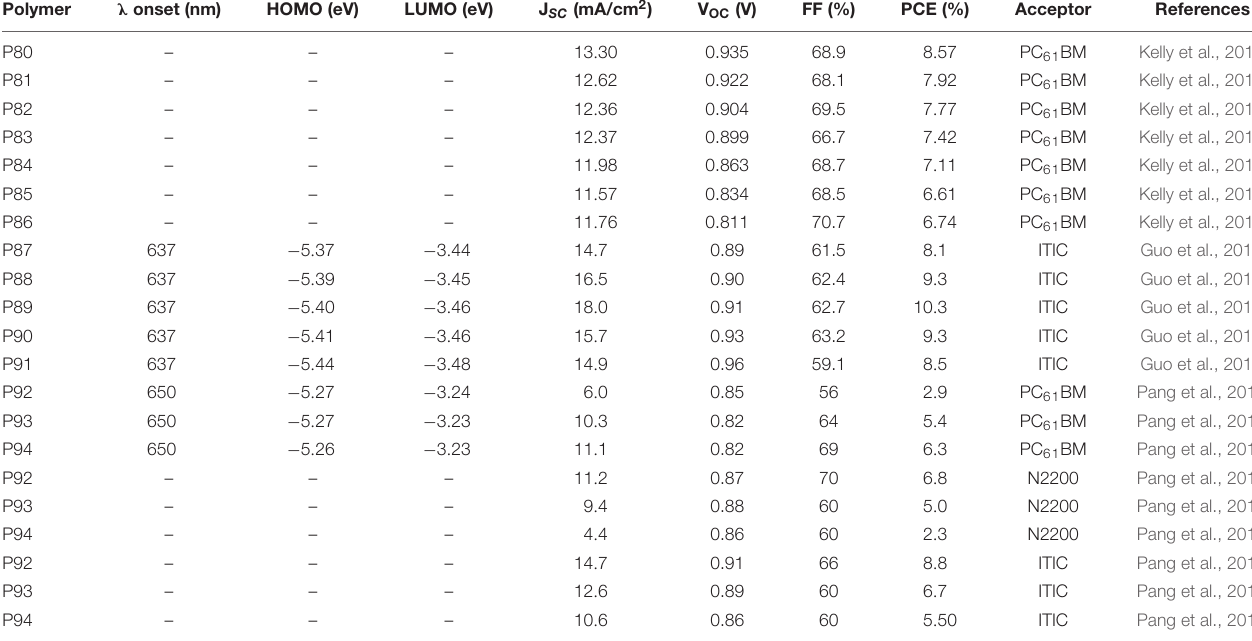
TABLE 7 | Summary of optical, electrochemical, and photovoltaic properties of polymers ( P80 – P94 ). Polymer λ onset (nm) HOMO